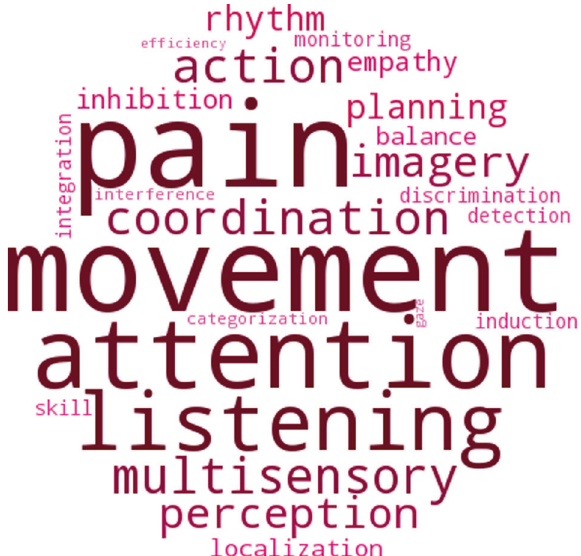
Fig. 4 Word cloud based on correlations with NeuroSynth meta- analysis maps across groups. Larger size and colour saturation indicate stronger correlation.